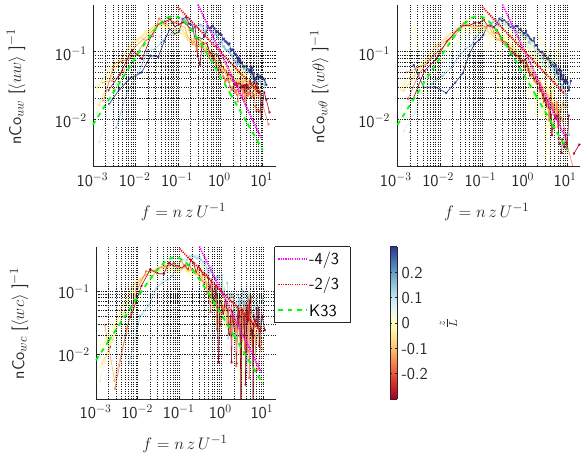
Figure B2. Normalised cospectra of momentum CO 2 and sensible heat bin averaged over based on the dimensionless stability param- eter. The dashed green curve shows Eq. (A1) (Kaimal et al., 1972). The magenta and red dotted lines indicate the expected slopes in the inertial subrange for Co and power spectra, respectively. Note that the cospectra are not normalised for the stability function; this would reduce the magnitude of the stable spectra and make them fall together with the unstable–neutral spectra in the inertial subrange.